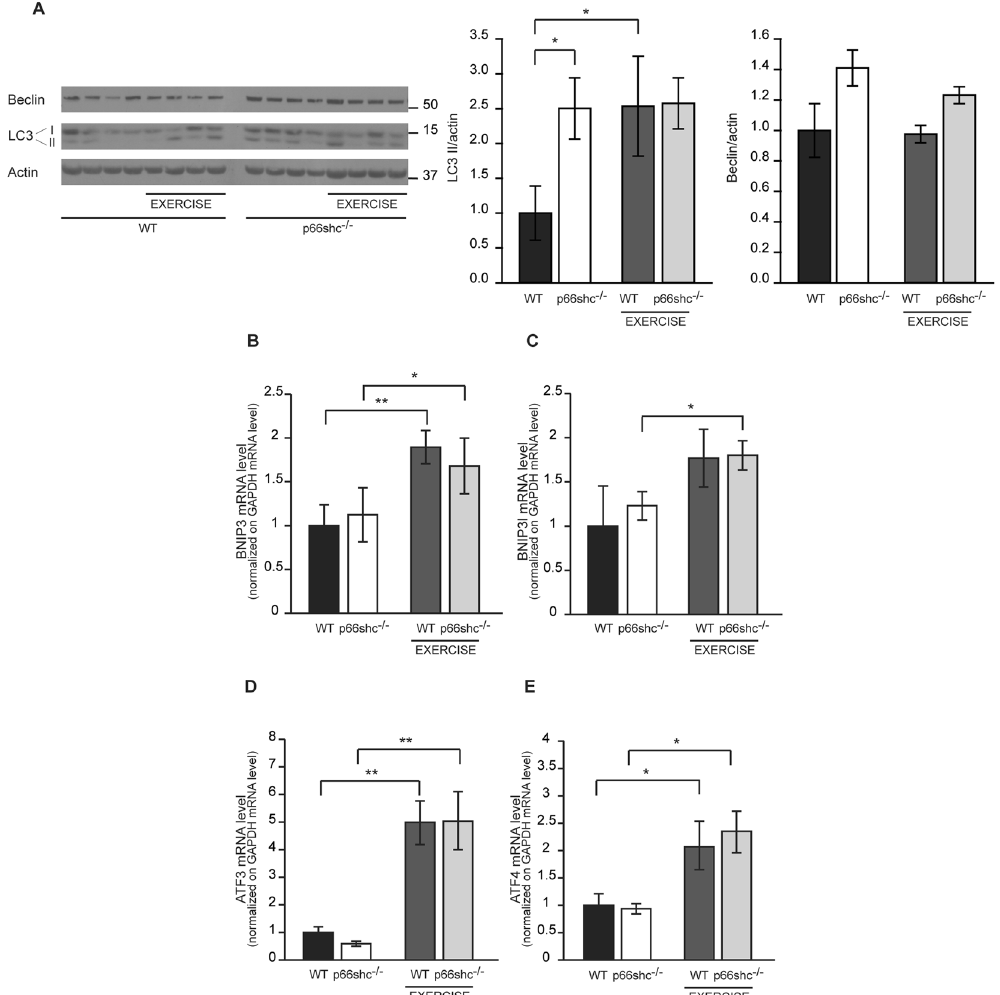
Figure 6. Muscle autophagy and ER stress are not regulated by p66shc in chow-diet treated mice. ( A ) Immunoblotting of gastrocnemius muscles of wt and p66shc − / − mice before and immediately after (exercise) a single bout of exhaustion running and quantification by densitometry. * p < 0.05, pairwise multiple comparison (Holm-Sidak method) of 4 animals per condition. Data are presented as mean ± SEM. Cropped blots are displayed, and full-length blots are presented in Supplementary Figure S1. ( B – E ) qRT-PCR for Bnip3 ( B ), Bnip3l ( C ), ATF3 ( D ) and ATF4 ( E ) transcripts. Data are normalized on GAPDH mRNA level. * p < 0.05, ** p < 0.01, pairwise multiple comparison (Holm-Sidak method) of 4 animals per condition. Data are presented as mean ±